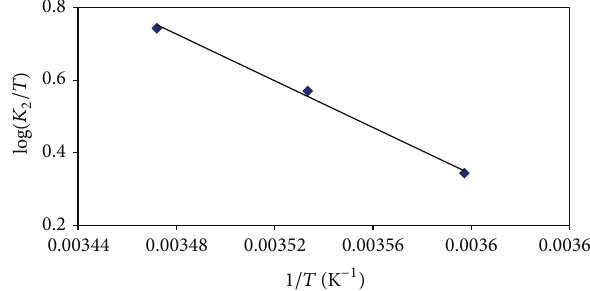
Figure 9: The relation between log 𝐾 2 / 𝑇 and 1/ 𝑇 for poly-o- phenylenediamine